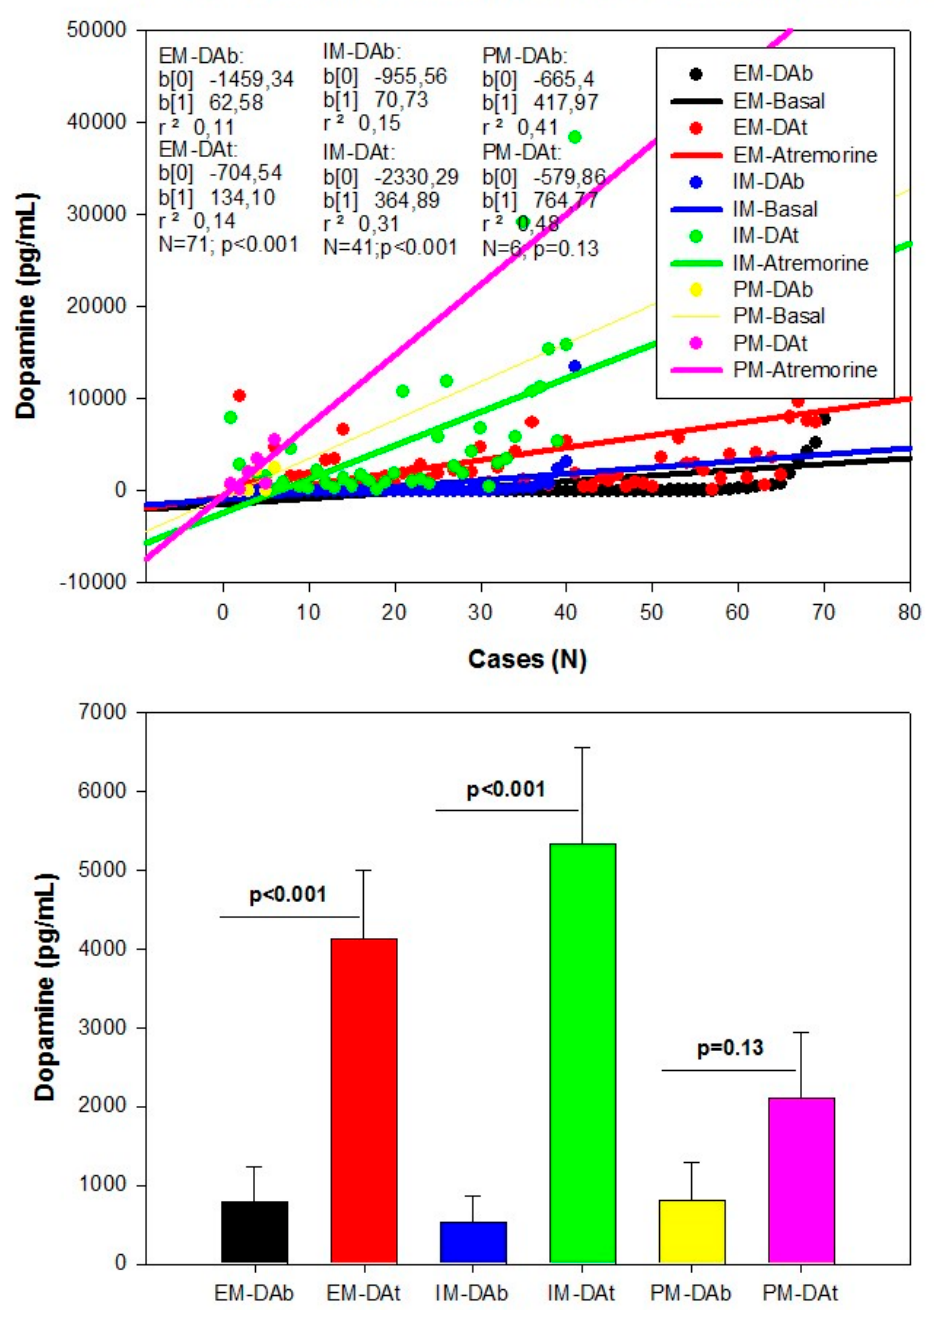
Figure 5. CYP2C9-related Atremorine-induced dopamine response. Basal (DAb) and Atremorine-induced dopamine response (DAt) in CYP2C9 extensive (EM), Intermediate (IM), and Poor metabolizers (PM). Adapted with permission from Cacabelos et al. [17].